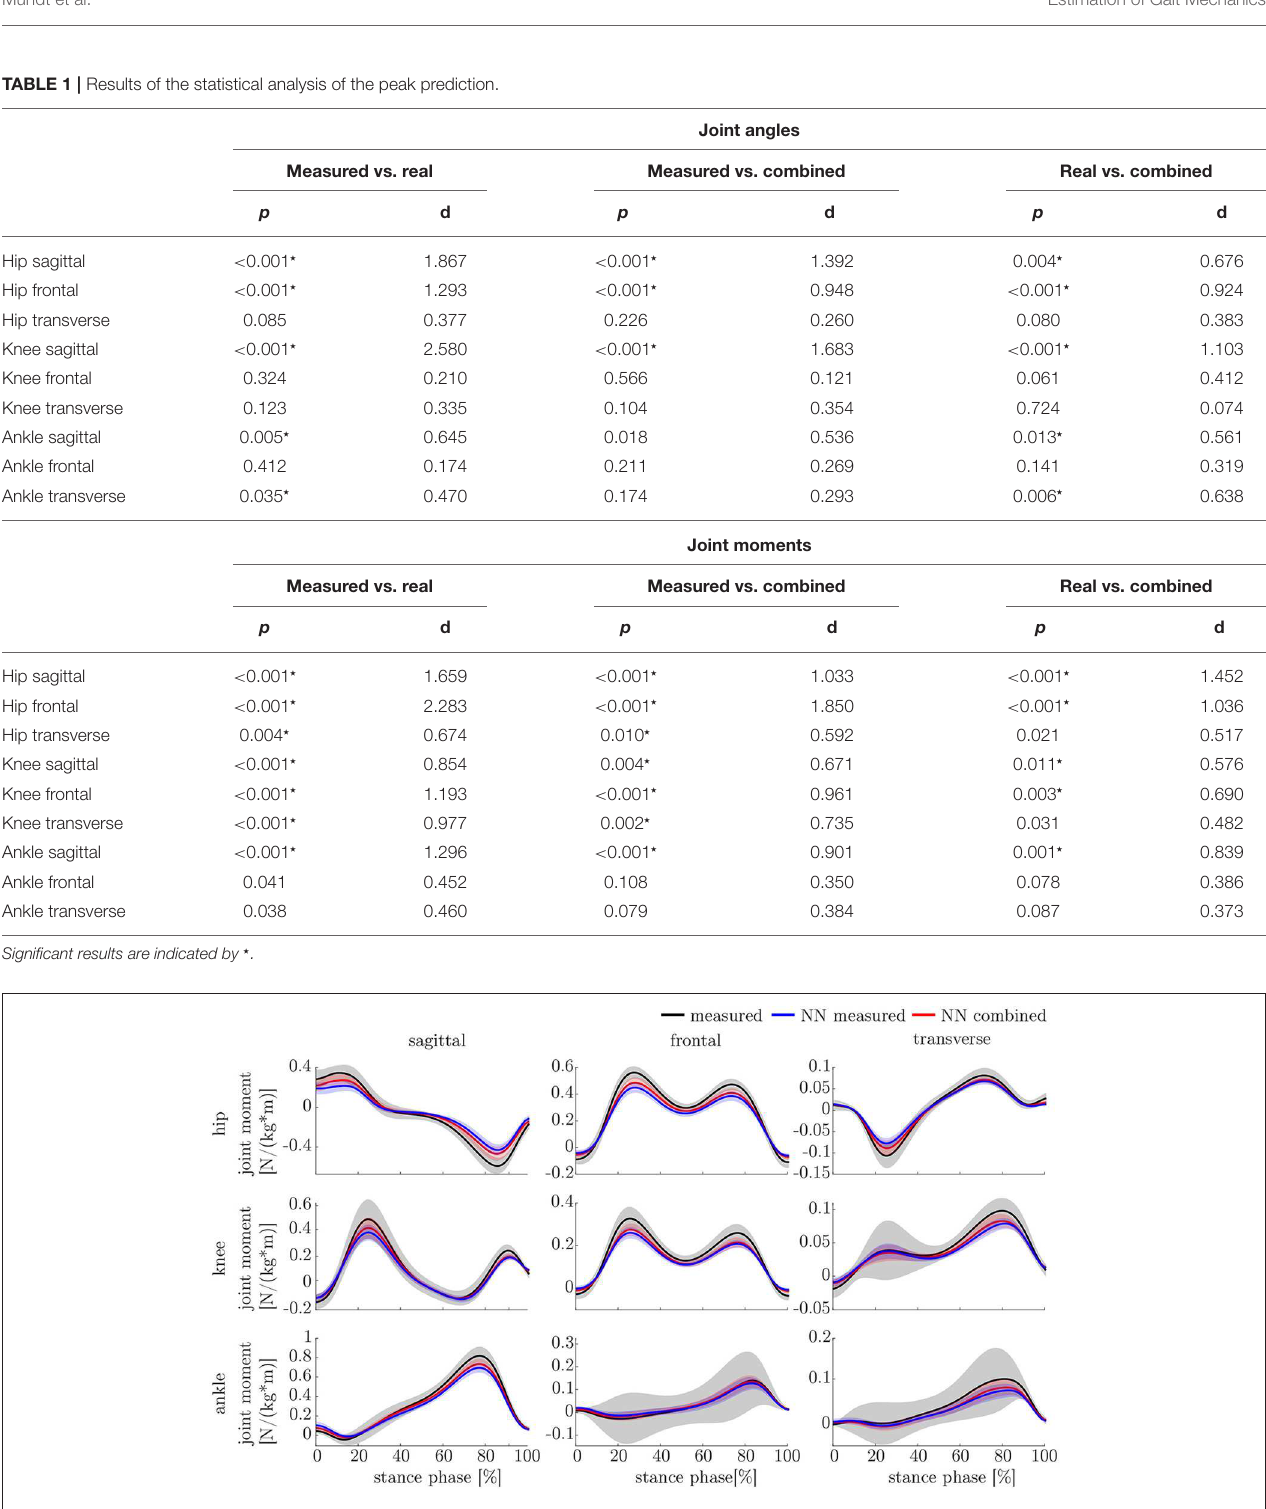
FIGURE 10 | Overview of the mean and standard deviation of the joint moments of the 23 subjects.